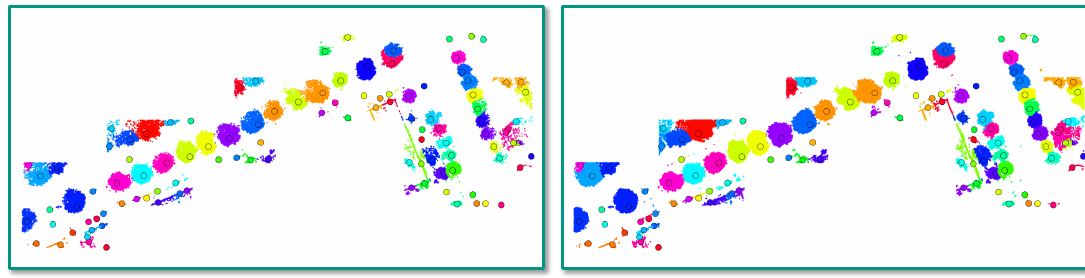
Figure 7. Visualization of a segmentation result relying on a classification based on the feature set S 3D+2D ( left : mean shift segmentation result; right : segmentation result after the upsampling to the “tree points”): the segment modes are indicated with a circle in the respective color (the segmentation result corresponds to the classification result depicted in Figure 5).